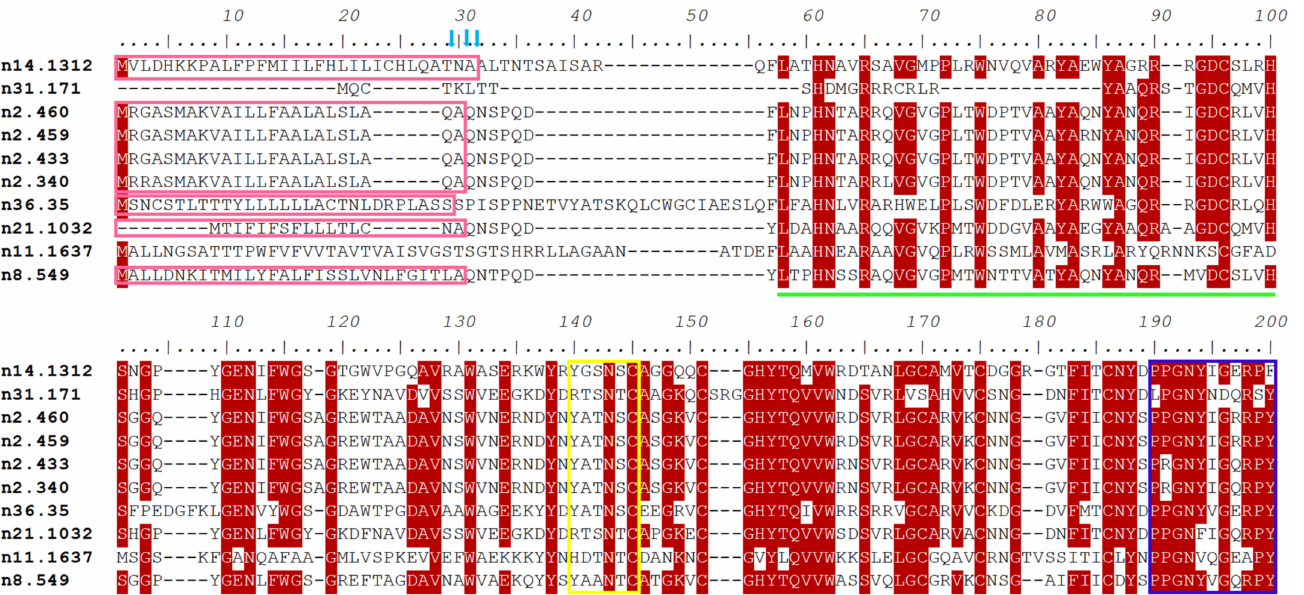
Figure 1. Multiple sequence alignments of the PnPR-1 protein sequences. The pink colored rectangle boxes indicate the signal peptide regions; the cleavage sites predicted are indicated by the blue arrowheads. The green line indicates the CAP domain structure of ~150 bp. The yellow and blue color rectangles show the caveolin-binding motif (CBM) and CAP-derived peptide (CAPE),